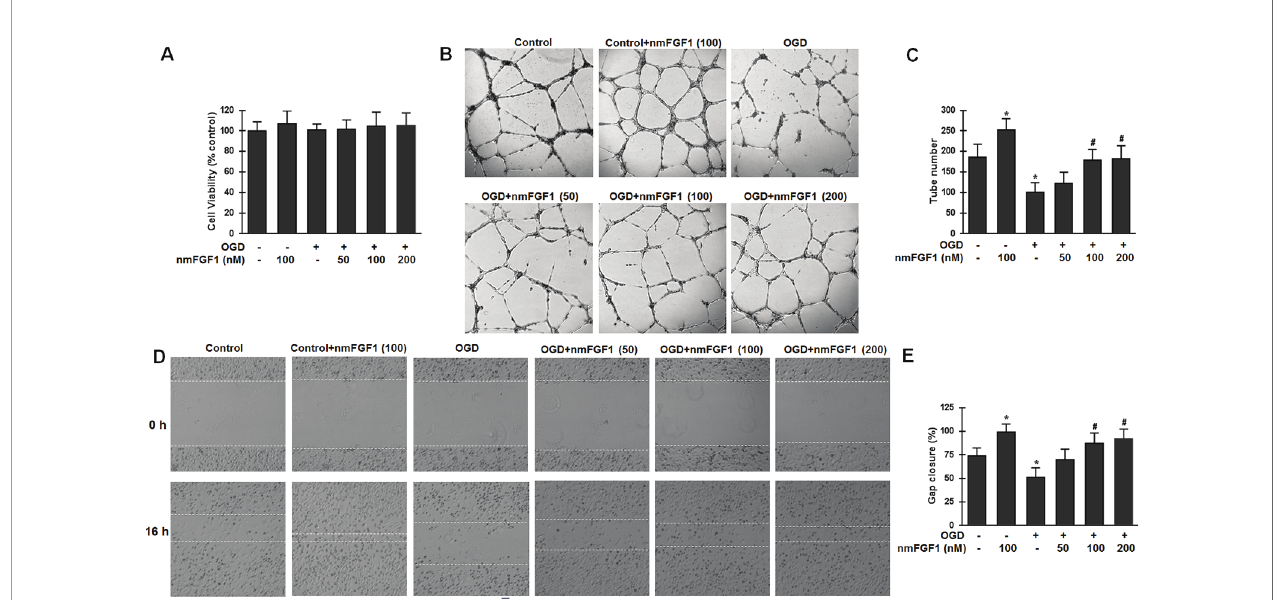
FIGURE 4 | Non-mitogenic fi broblast growth factor 1 (nmFGF1) enhanced angiogenesis and wound healing in oxygen-glucose deprivation (OGD)-exposed HBMECs without affecting viability. (A) OGD and three concentrations of nmFGF1 (50, 100, and 200 nm) had no effect on cell viability. (B) Representative images to study the effect of OGD exposure and nmFGF1 treatment on tube formation ability of cells. (C) Quanti fi cation of the effects of nmFGF1 on the number of capillary-like tubes in OGD-treated cells. (D) Representative images to study the effect of nmFGF1 on wound healing in OGD-stimulated cells. (E) Quanti fi cation of the effects of nmFGF1 on wound closure in OGD-treated cells. Date are expressed as means ± SEM (n = 6). *p < 0.05 as compared to the control group, # p < 0.05 as compared to the OGD-treated